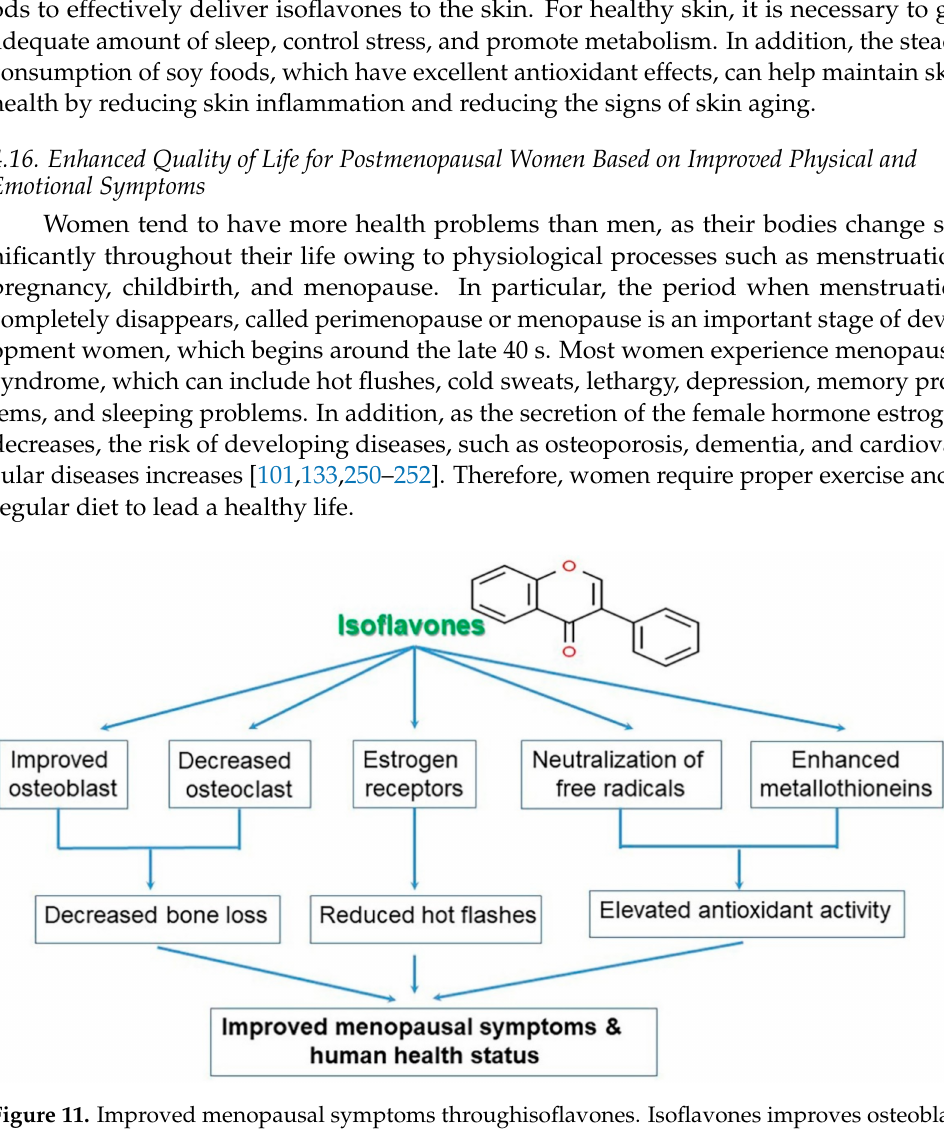
Figure 11. Improved menopausal symptoms throughisoflavones. Isoflavones improves osteoblast, estrogen receptor beta-binding capacity, reactive oxygen species-neutralization ability, including enzymatic antioxidant systems (e.g., metallothioneins), and they decrease osteoclast frequently. Therefore, isoflavones prevent bone loss and hot flashes, and enhance antioxidant activity, thereby ameliorating the menopausal symptoms and improving human health status